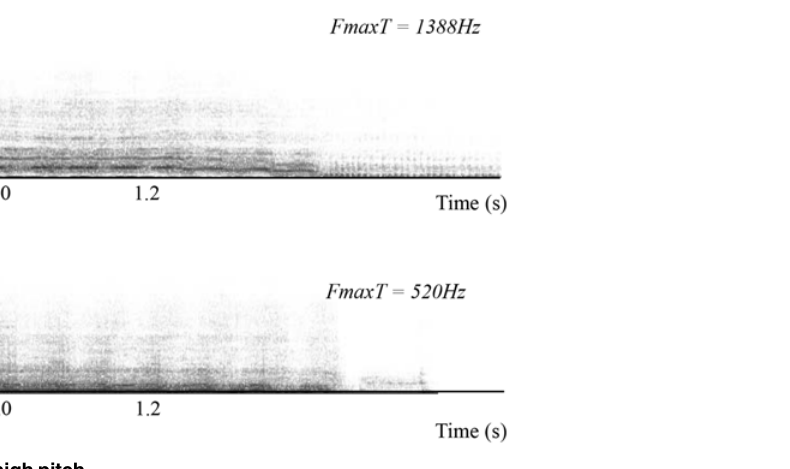
Fig 4. Acoustic stimuli spectrograms (a) low pitch and (b) high pitch.